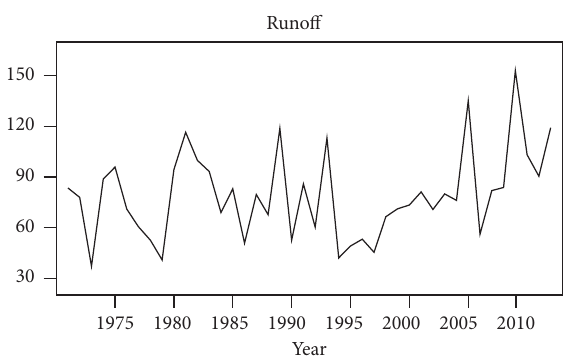
Figure 3: The time series of the runoff at Zhimenda station in the flood season during 1971–2012 (unit: × 10 8 m 3 ).